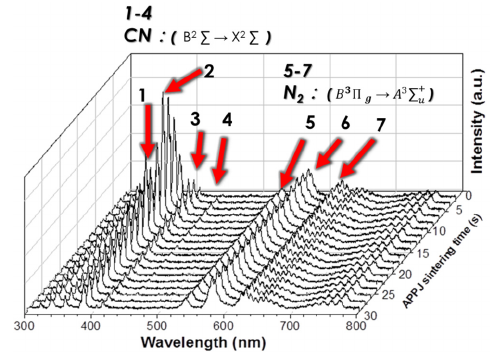
Figure 3. Plasma spectrum evolution during APPJ sintering on samples with added 100 µ L H 2 PtCl 6 solution.